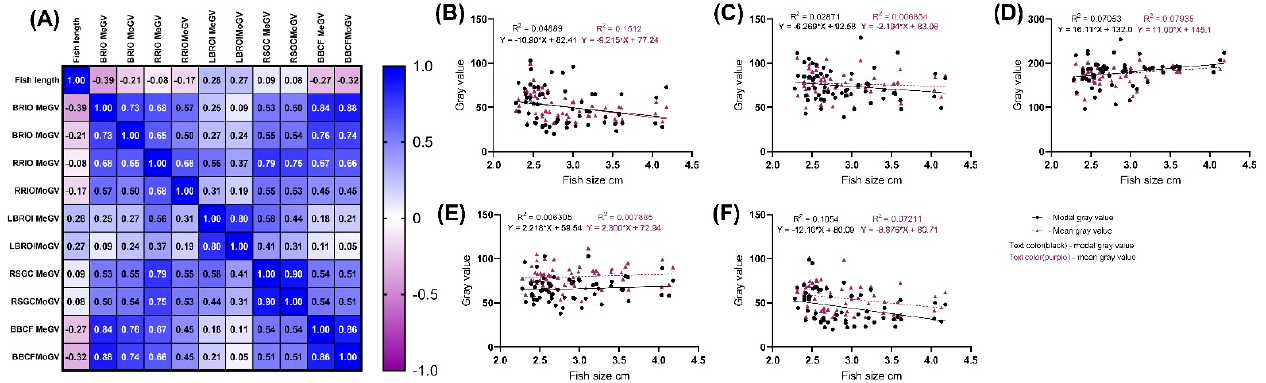
Figure 3. Linear regression of MoGV and MeGV parameters as a function of male N. guentheri size. ( A ) Person’s correlation matrix between different zone. ( B ) BROI linear regression; ( C ) LBRIO linear regression; ( D ) RROI linear regression; ( E ) BBCF linear regression; ( F ) RSGC linear regression. Table 1. Numerical measurement data and the MoGVs for the two sets of zones in the entire sample. The value ( p < 0.05) from unpaired t -test with Welch’s correction.